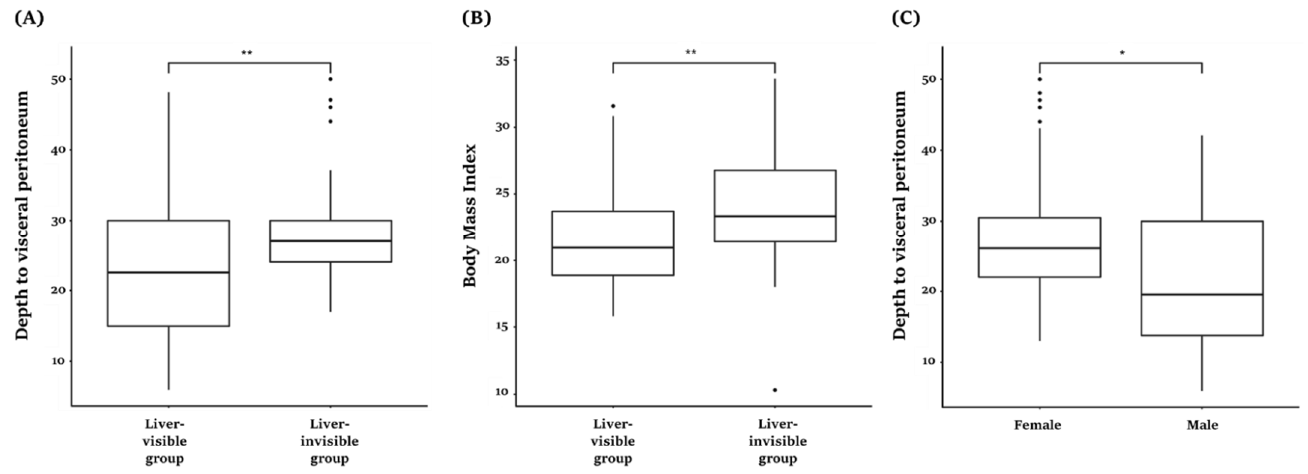
Figure 5. boxplot graph of acupoint CV12. * p < 0.05, ** p < 0.01. Figure 5. Boxplot graph of acupoint CV12. * p < 0.05, ** p <